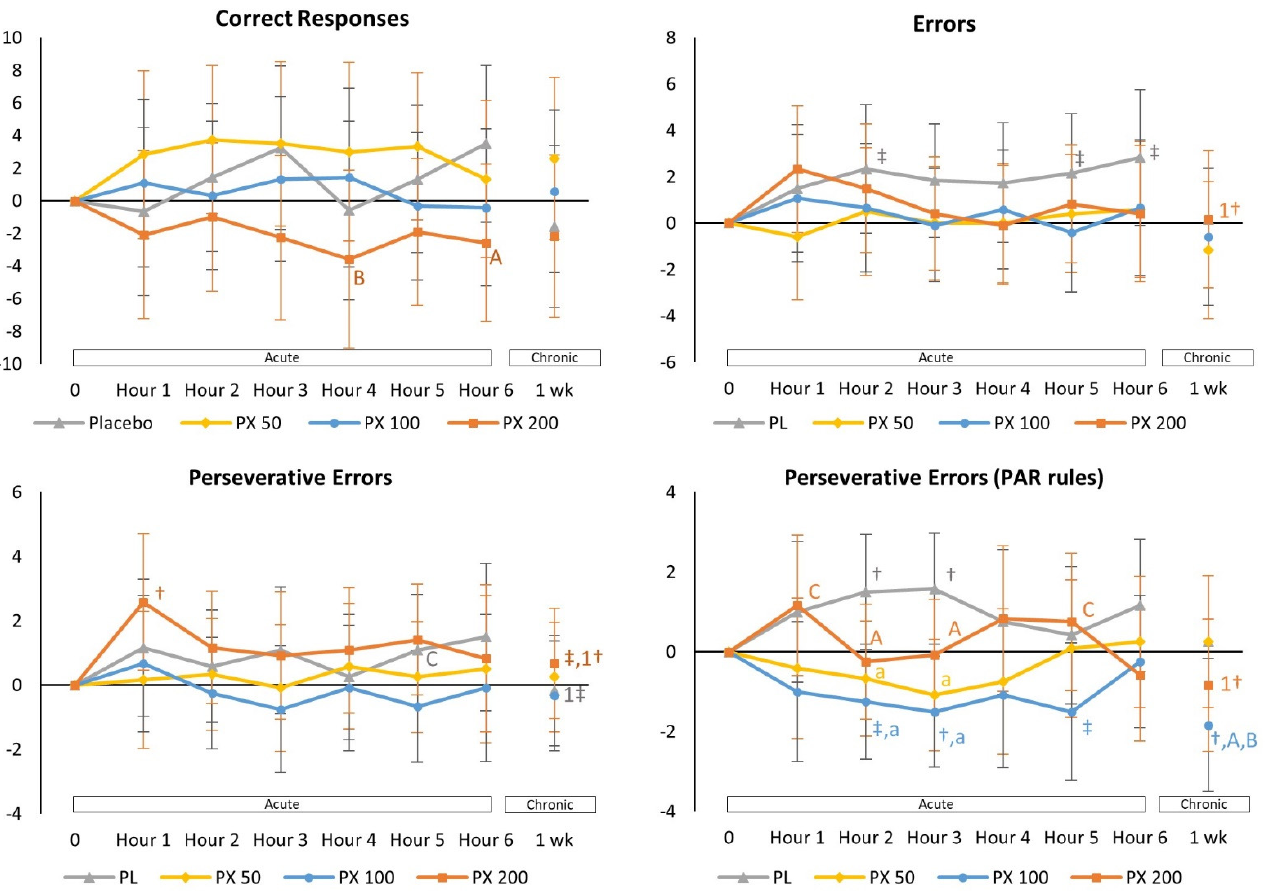
Figure 3. Mean changes with 95% confidence interval data from baseline in Berg-Wisconsin Card Sorting Test. † = p < 0.05 (‡ = p > 0.05 to p < 0.10) from baseline. 1† = p < 0.05 from Day1–1 h value. Treatment differences are denoted as from PLA: a = p < 0.05 (A = p > 0.05 to p < 0.10); PXN 50: b = p < 0.05 (B = p > 0.05 to p < 0.10); PXN 100: c = p < 0.05 (C = p > 0.05 to p < 0.10); and PXN 200: d = p < 0.05 (D = p > 0.05 to p < 0.10).